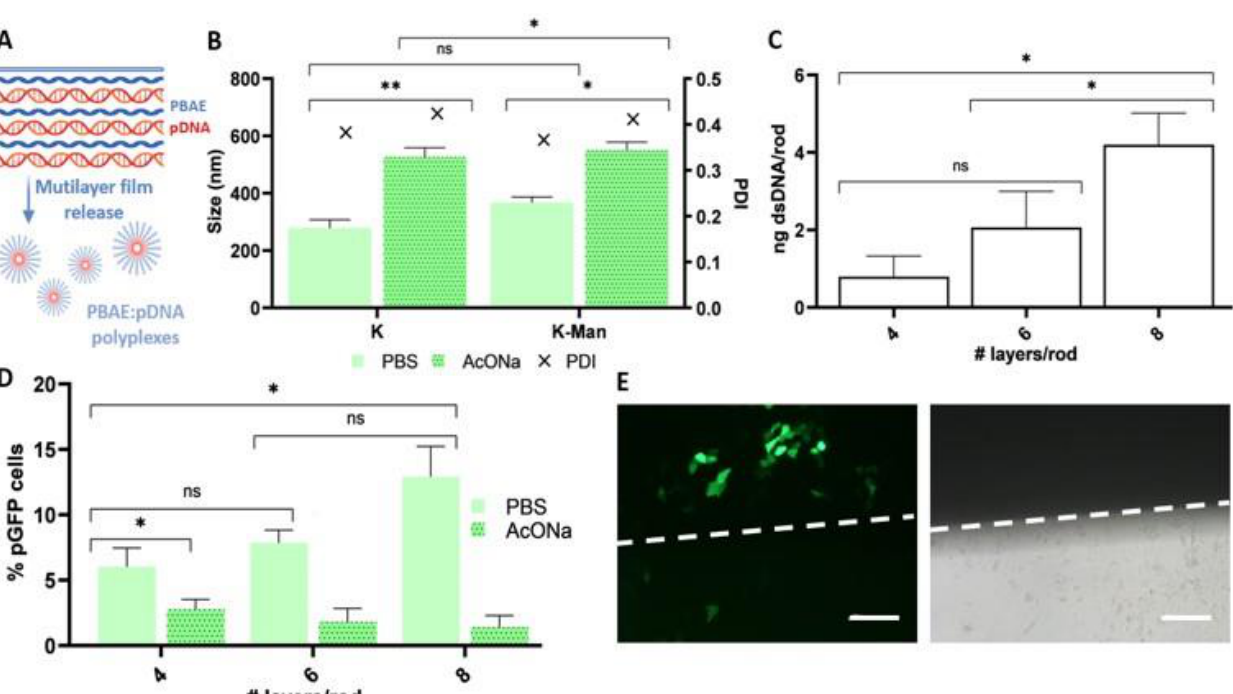
Figure 5. Schematic representation of in situ polyplex formation from PBAE:pDNA polyelectrolyte films ( A ). Hydrodynamic diameter (left y axis; bars) and PDI (right y axis; symbols) of polyplexes derived from K and K-Man-PBAEs (2:1 polymer-to-DNA ratio) upon release from PCL substrates. Polyelectrolyte films were deposited using PBS or AcONa as dilution buffer ( B ). Fluorescence quan- tification of dsDNA from eroded films prepared with PBS and quantified with the High Sensitivity Quant-iT™ dsDNA Assay Kit ( C ). Evaluation of pGFP expression in HaCaT cells following trans- fection with PCL rods coated with K-Man-PBAE:pDNA films by flow cytometry ( D ). Fluorescence versus bright field microscopy served to confirm local transfection. Dashed lines delimit area in contact with films. Scale bar = 50 µm ( E ). Data are represented as mean ± SD (ns = non-significant, * p < 0.05, ** p < 0.01).